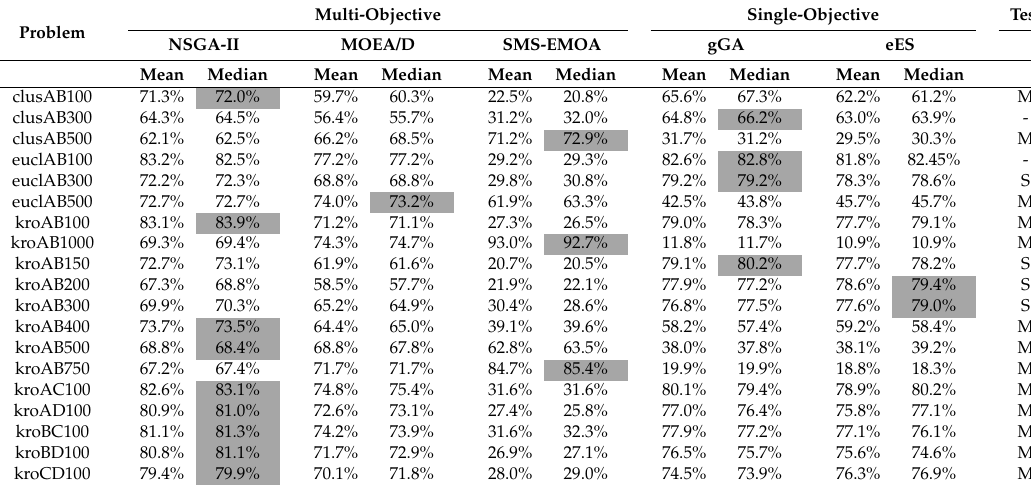
Table 7. Results for TSP instances (objective 1).